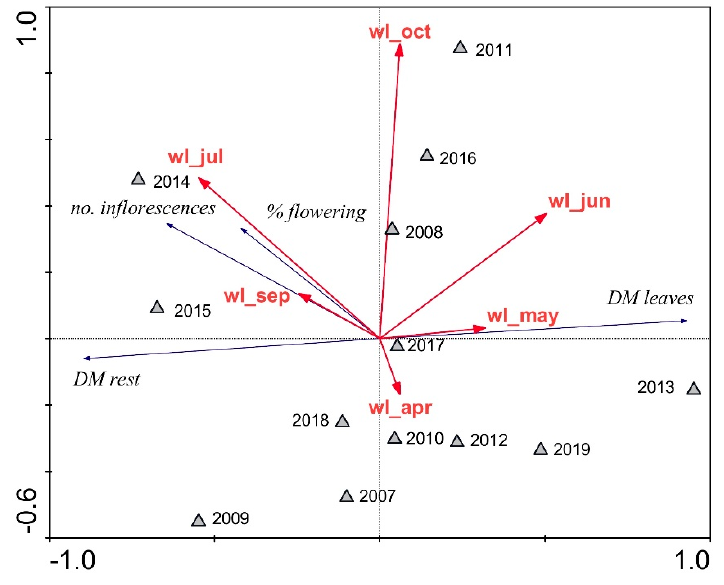
Figure 5. Redundancy analysis plot showing the strengths of the associations between monthly water